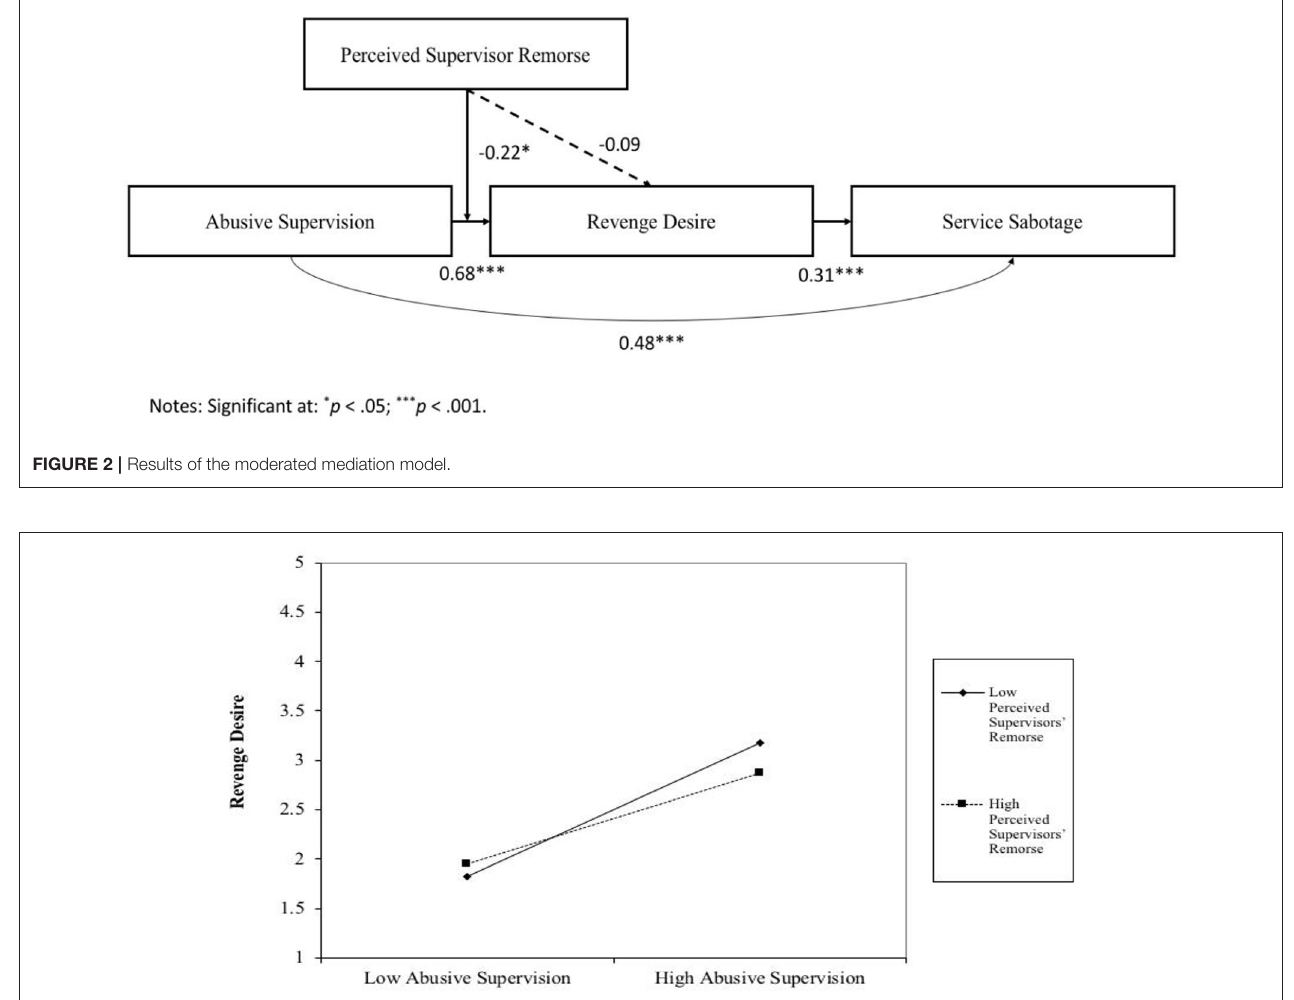
FIGURE 3 | The interaction of abusive supervision and PSR on revenge desire.